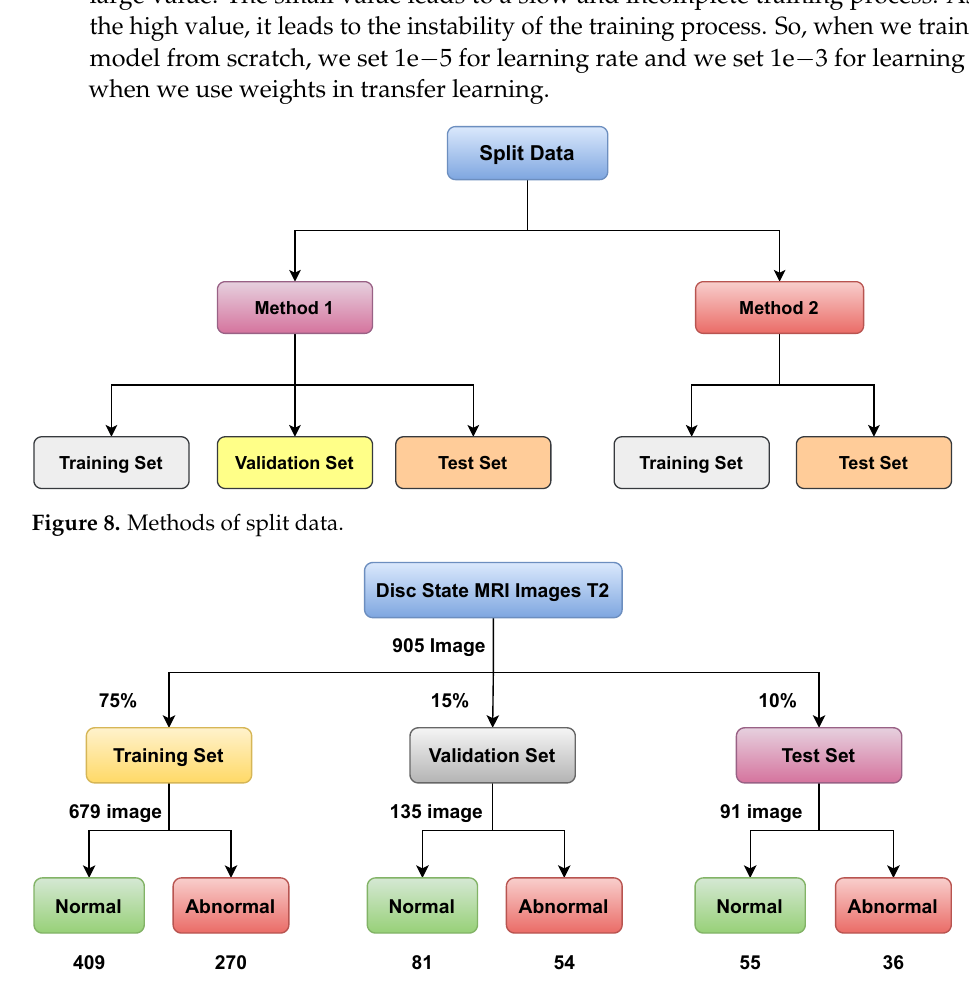
Figure 9. Split data of disc state into three groups: training, validation, and test